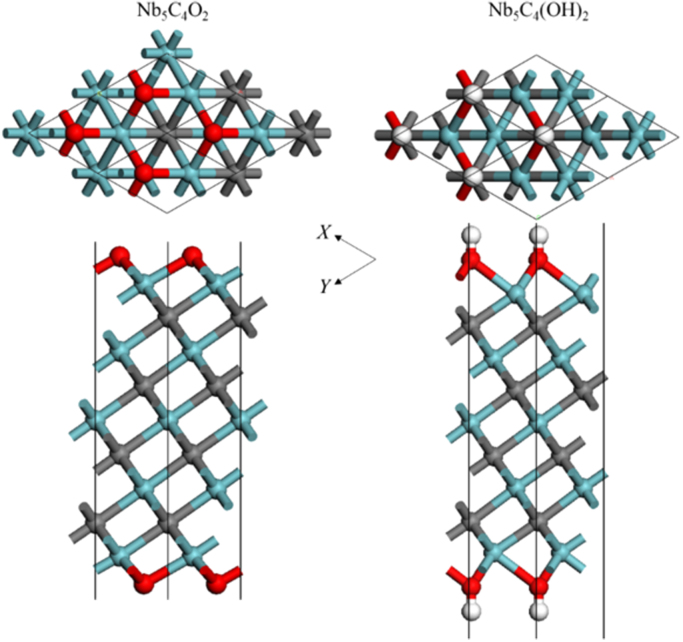
Top views and side views from the X direction of the optimal structures of Nb5C4O2 and Nb5C4(OH)2. The atoms represented by different color balls are the same as in Fig. 2.